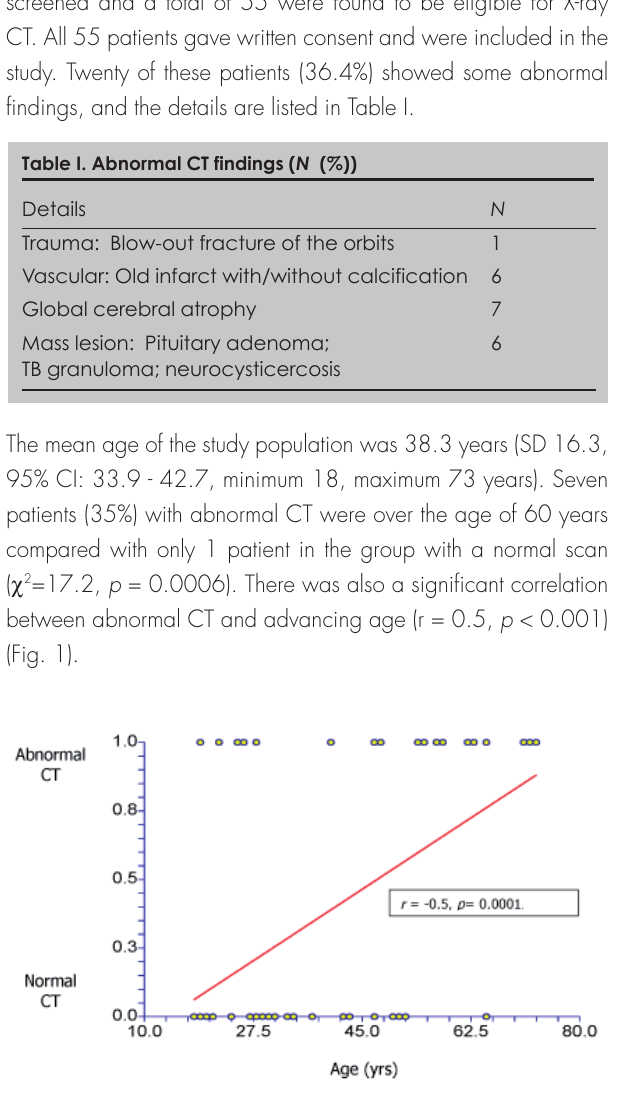
Fig. 1. Correlation between abnormal X-ray CTs and